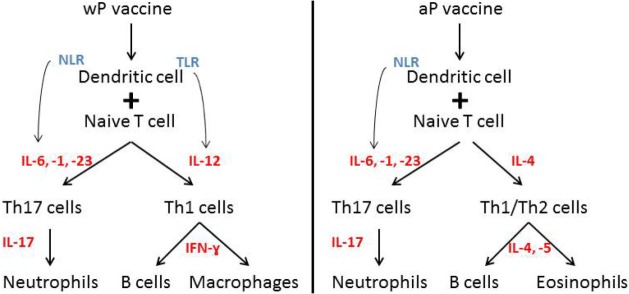
Immue response after wP versus aP vaccination. Different immune responses after wP versus aP vaccination. Distinct cytokine induction leads to the induction of different immune cells. Notation: IL, interleukin; NLR, NOD-like receptor; TLR, Toll-like receptor.